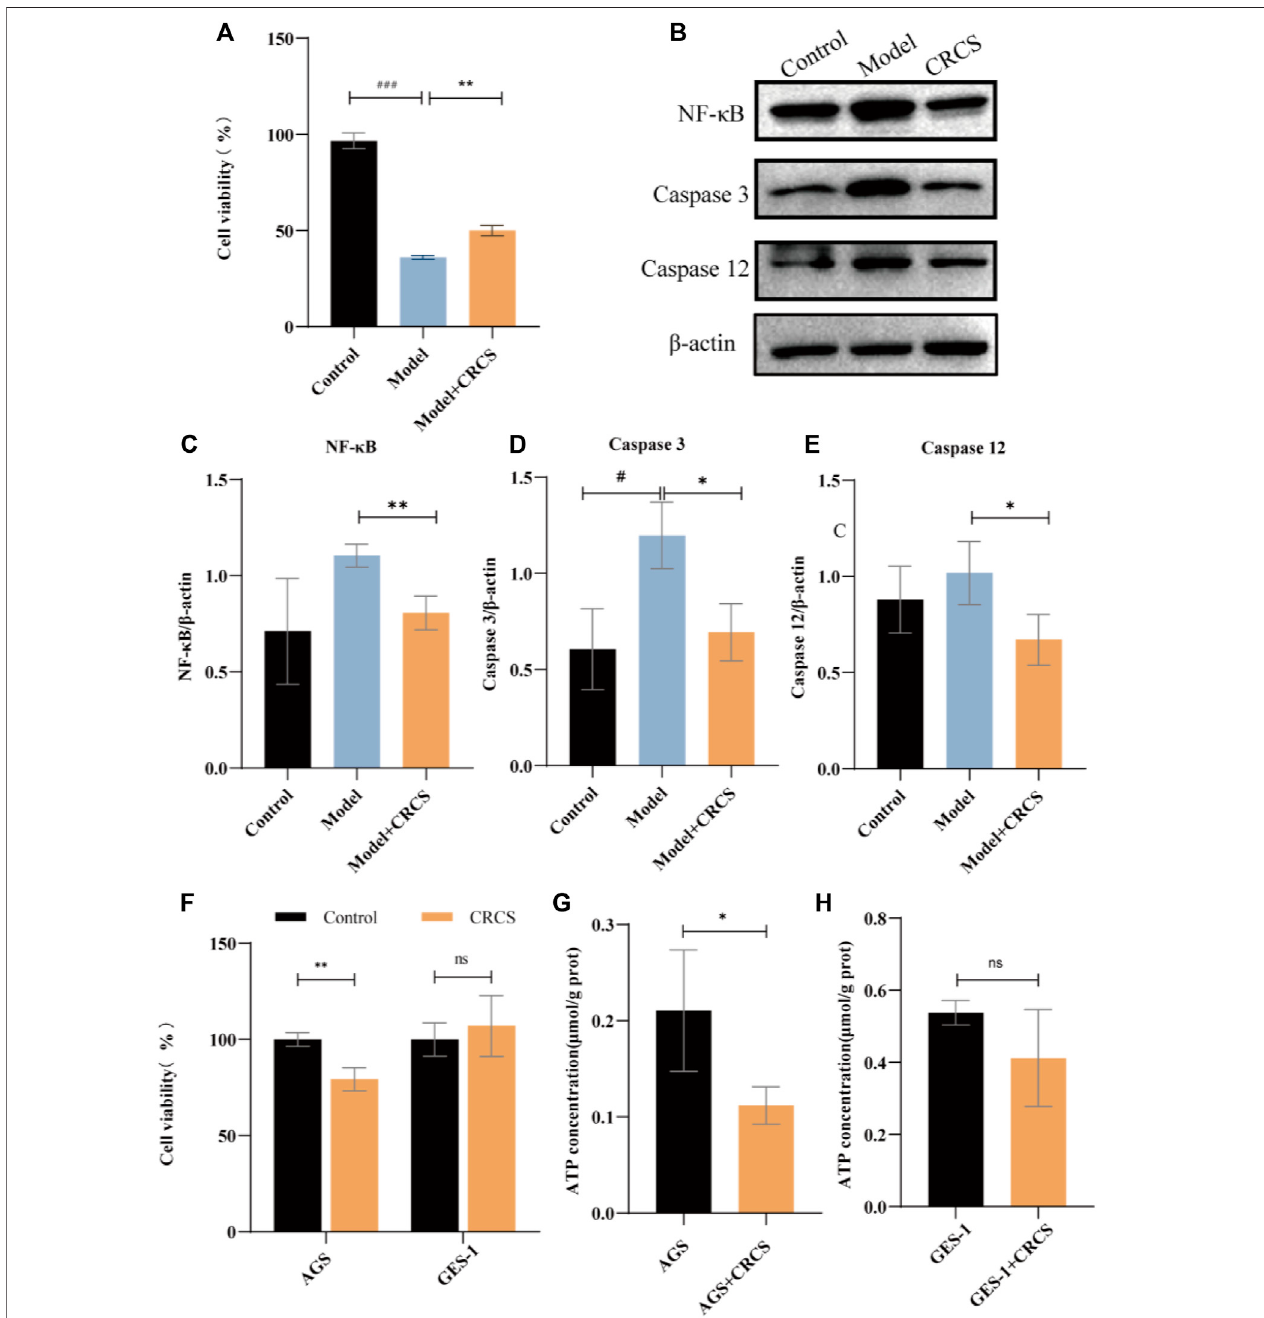
FIGURE 4 | CRCS ’ s anti-in fl ammatory and anti-gastric-cancer effect on MNNG-induced GES-1 cells and AGS cells. (A) MTS assay of CRCS on MNNG- induced in fl ammatory GES-1 cells. (B) Western blots of in fl ammatory factors (NF- κ B) and apoptosis factors (Caspase three and Caspase 12) in GES-1 cells (Control) and in fl ammatory GES-1 cells induced by MNNG (Model). (C) Western blotting analysis of NF- κ B in in fl ammatory GES-1 cells treated with CRCS. (D) Western blotting analysis of Caspase three in in fl ammatory GES-1 cells treated with CRCS. (E) Western blotting analysis of Caspase nine in in fl ammatory GES-1 cells treated with CRCS. (F) MTS assay of CRCS ’ s effects on AGS and GES-1 cells. (G) ATP contents in AGS cells treated with CRCS or not. (H) ATP contents in GES-1 cells treated with CRCS or not. β -actin served as the internal control in all Western blots. Data are presented as the mean ± SD, * p < 0.05, ** p < 0.01, *** p < 0.001, n = 3 per group.